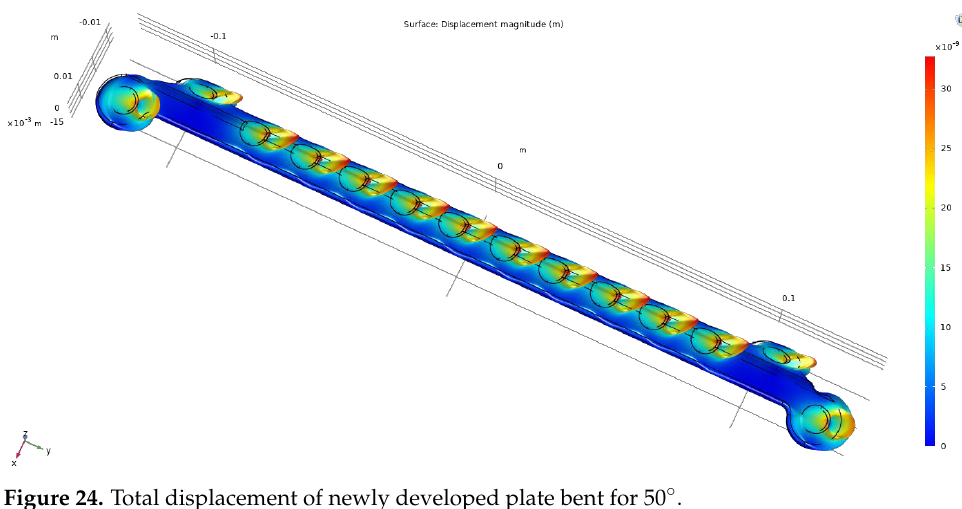
Figure 24. Total displacement of newly developed plate bent for 50°.